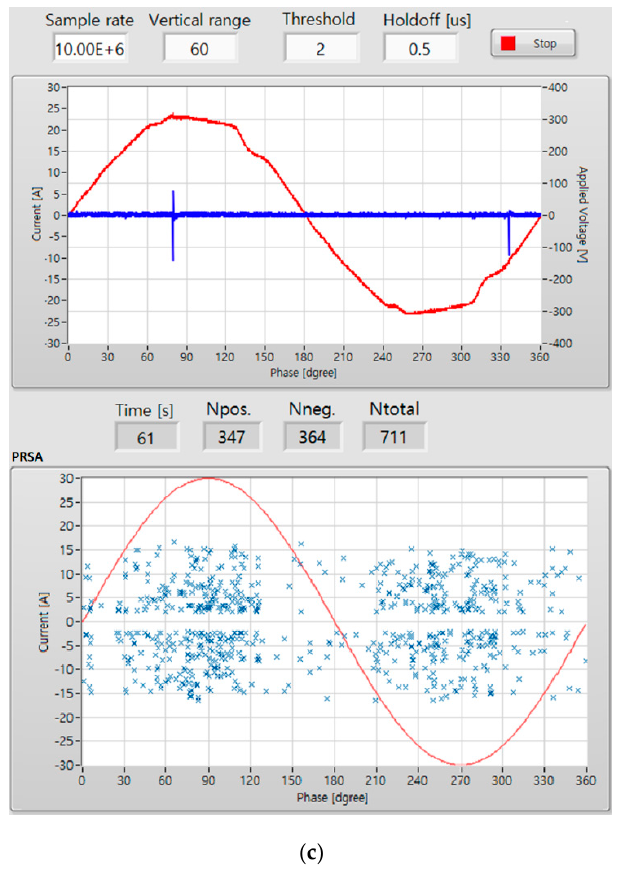
Figure 6. PRSA analysis method. ( a ) Flowchart; ( b ) program; ( c ) data processing panel.